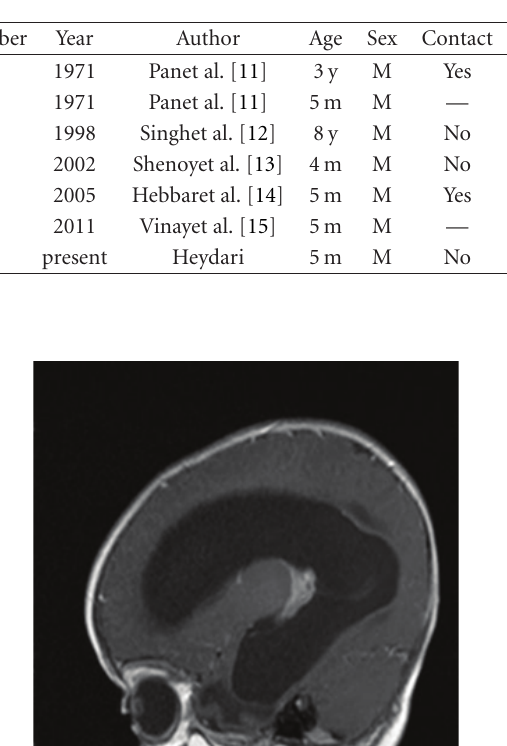
Table 1: Pediatric amoebic meningoencephalitis reports.